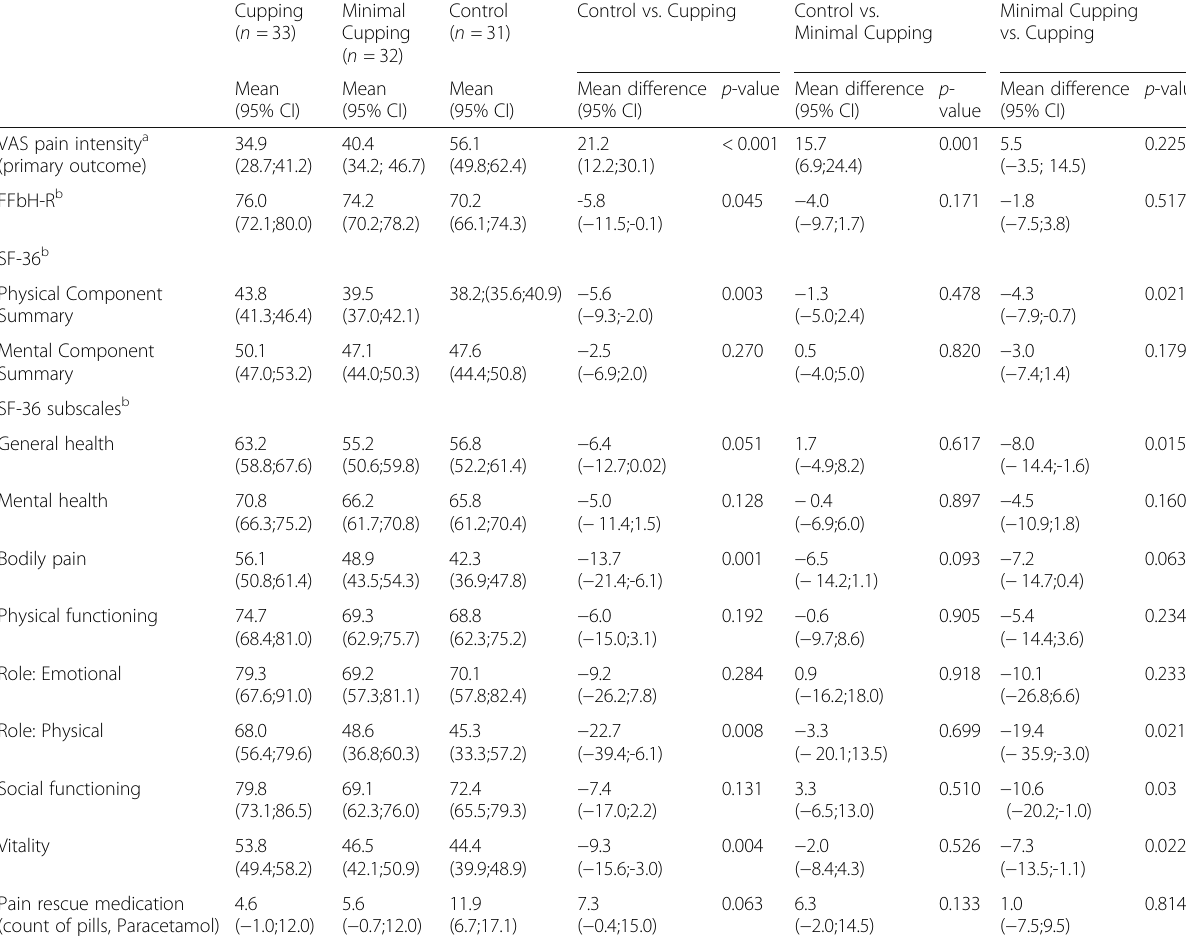
Table 2 Primary and secondary outcomes at week 4: group means and mean group differences with 95% confidence interval (CI), adjusted for respective baseline value